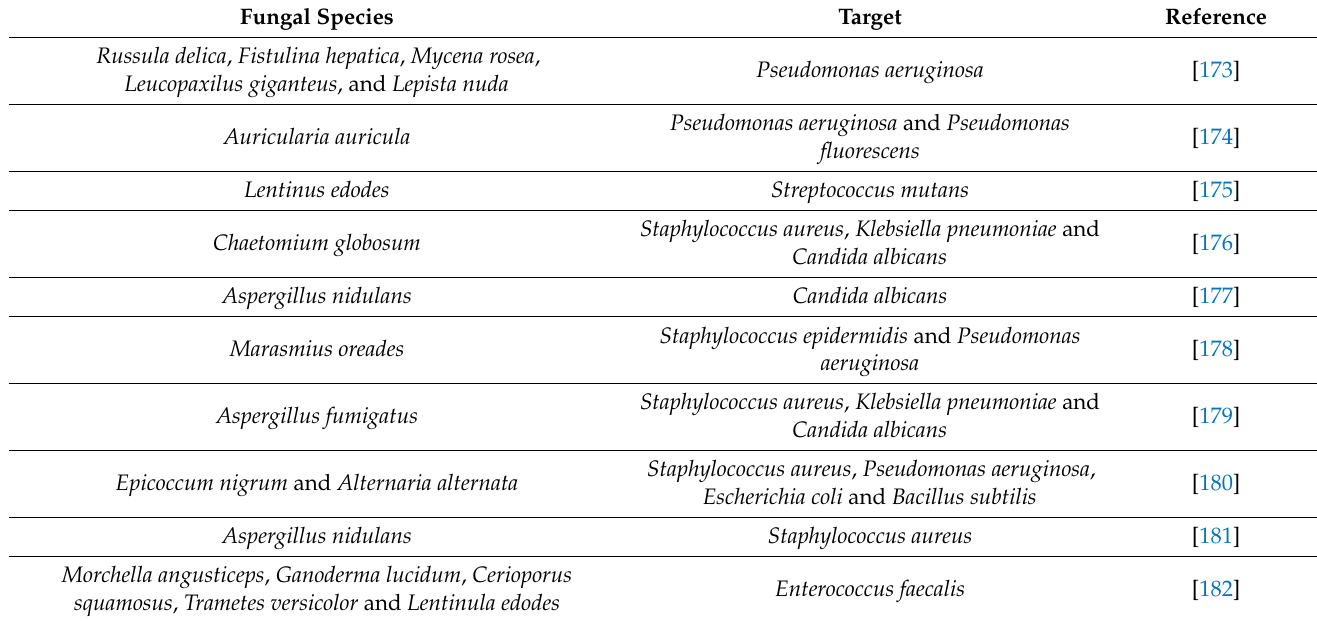
Table 3. Examples of fungal species with anti-biofilm